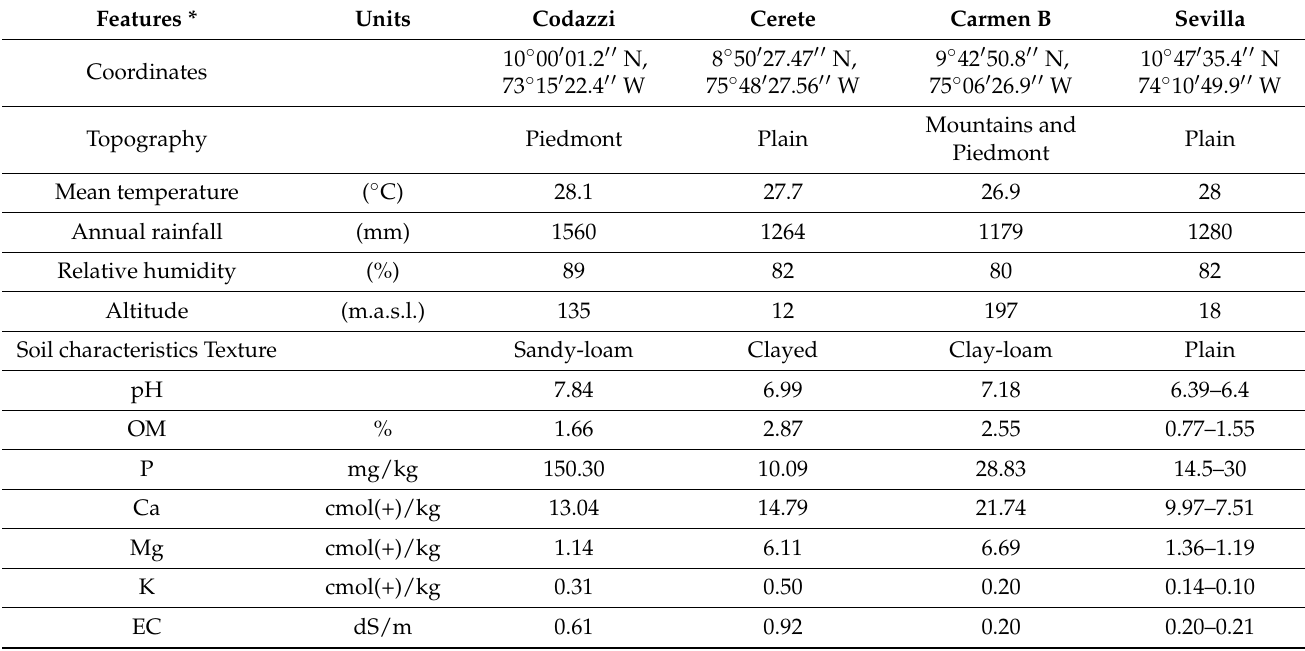
Table 1. Locations description and soil